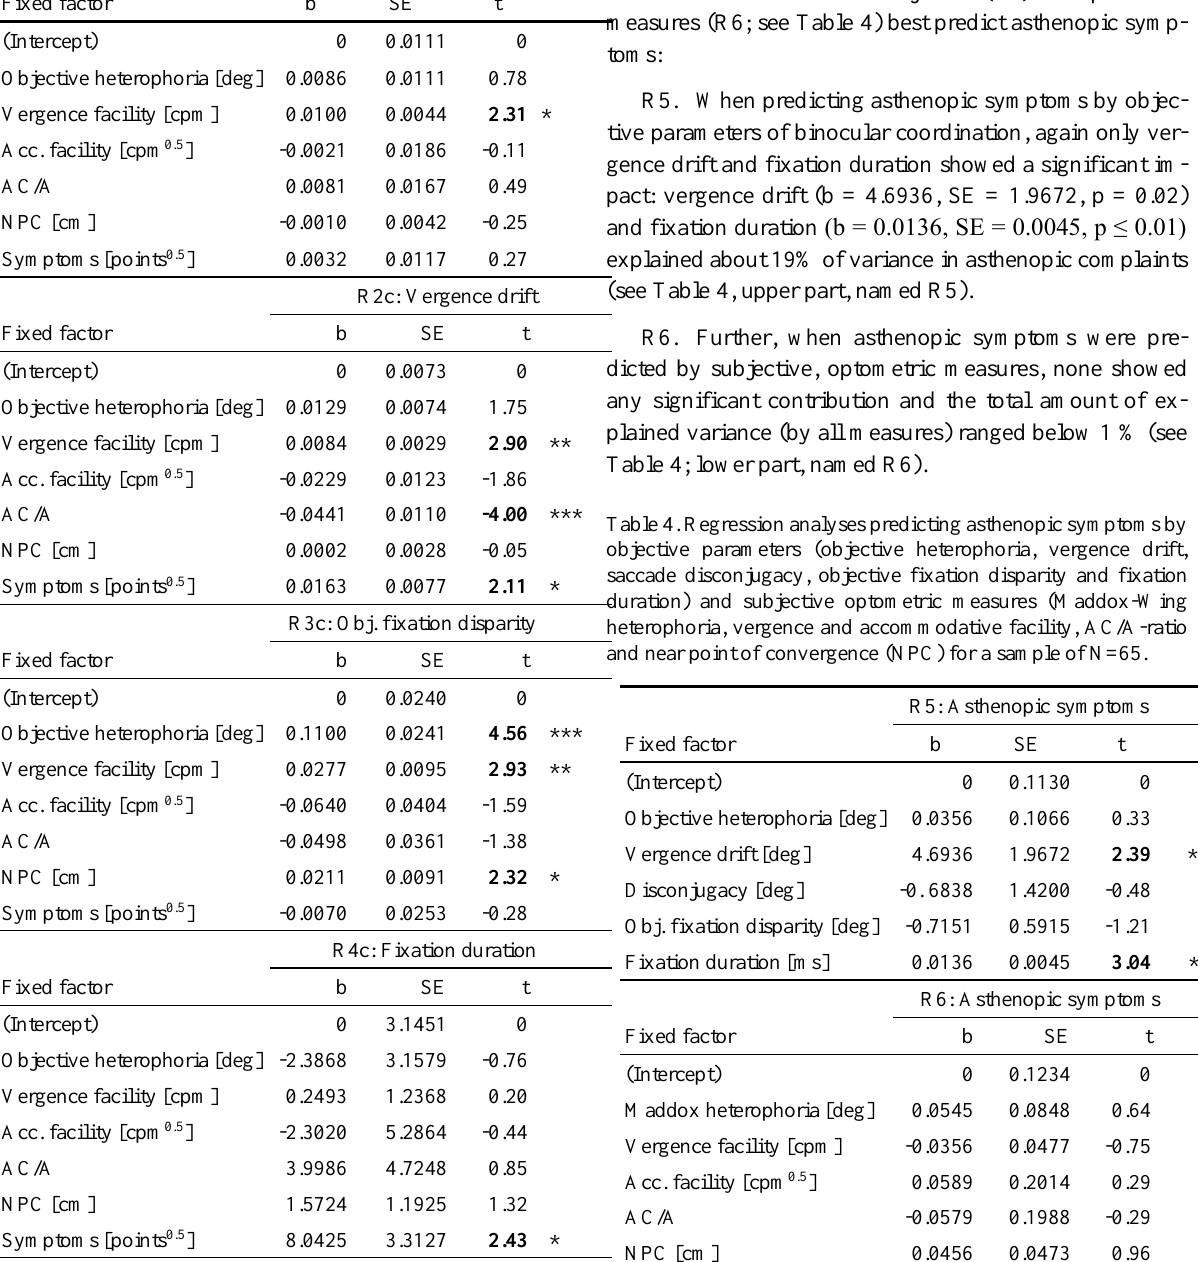
Table 3. Regression analyses predicting parameters of binocular coordination during reading by heterophoria, vergence and accommodative facility, AC/A-ratio, near point of convergence (NPC) and asthenopic symptoms for a sample of N=65.